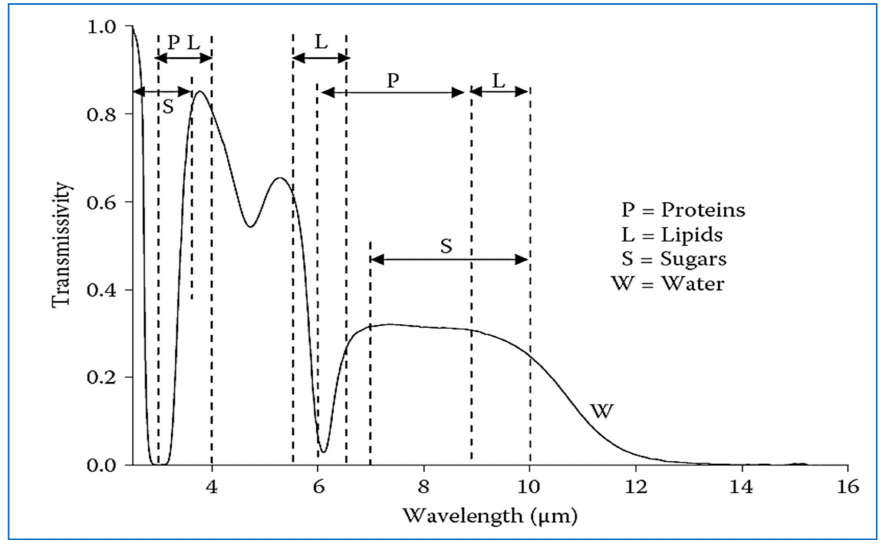
Figure 4. Principal absorption bands of the main food components compared with water